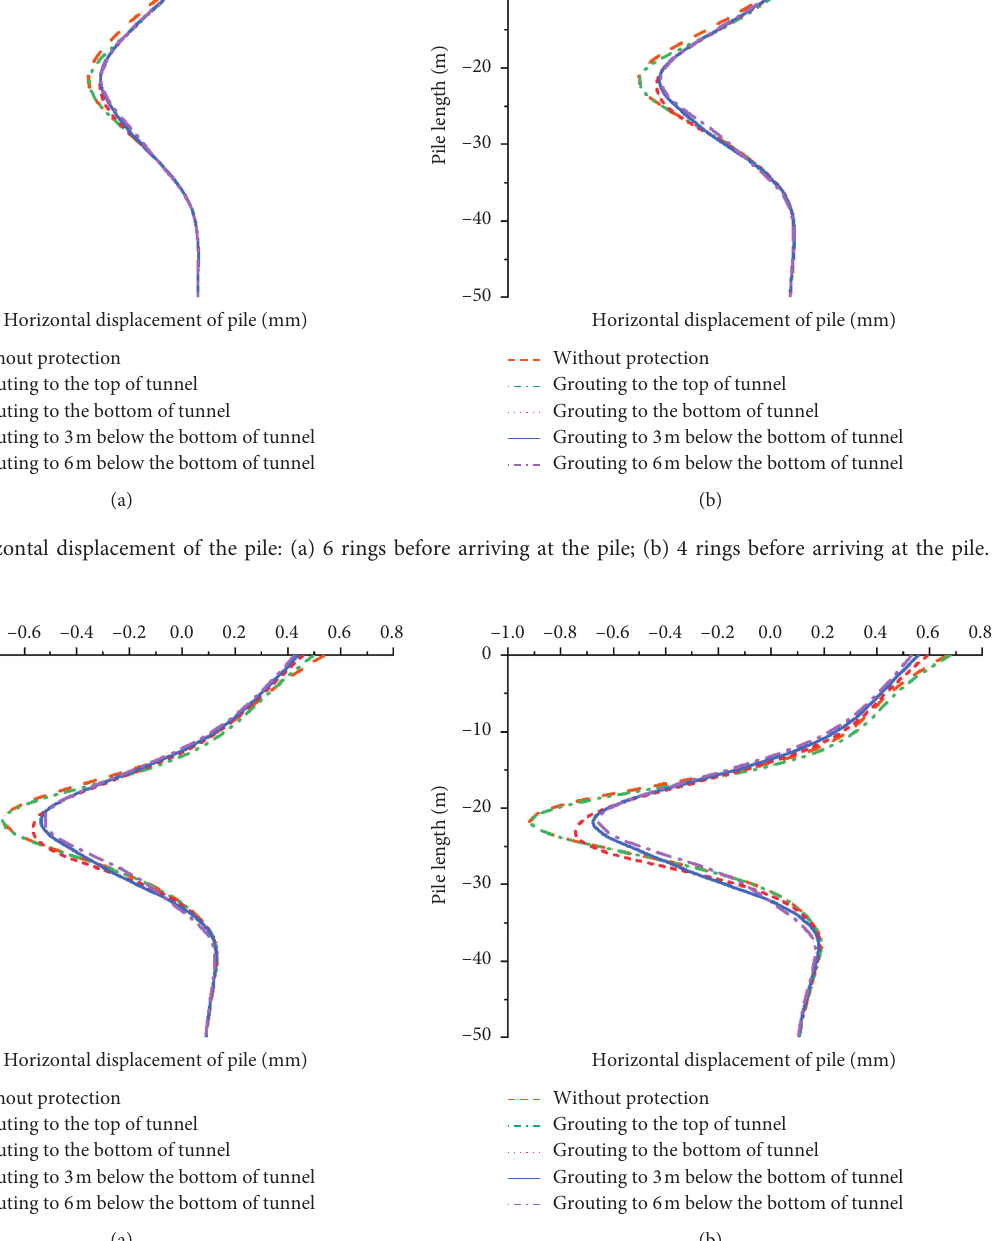
Figure 11: Horizontal displacement of the pile: (a) 2 rings before arriving at the pile; (b) arriving at the